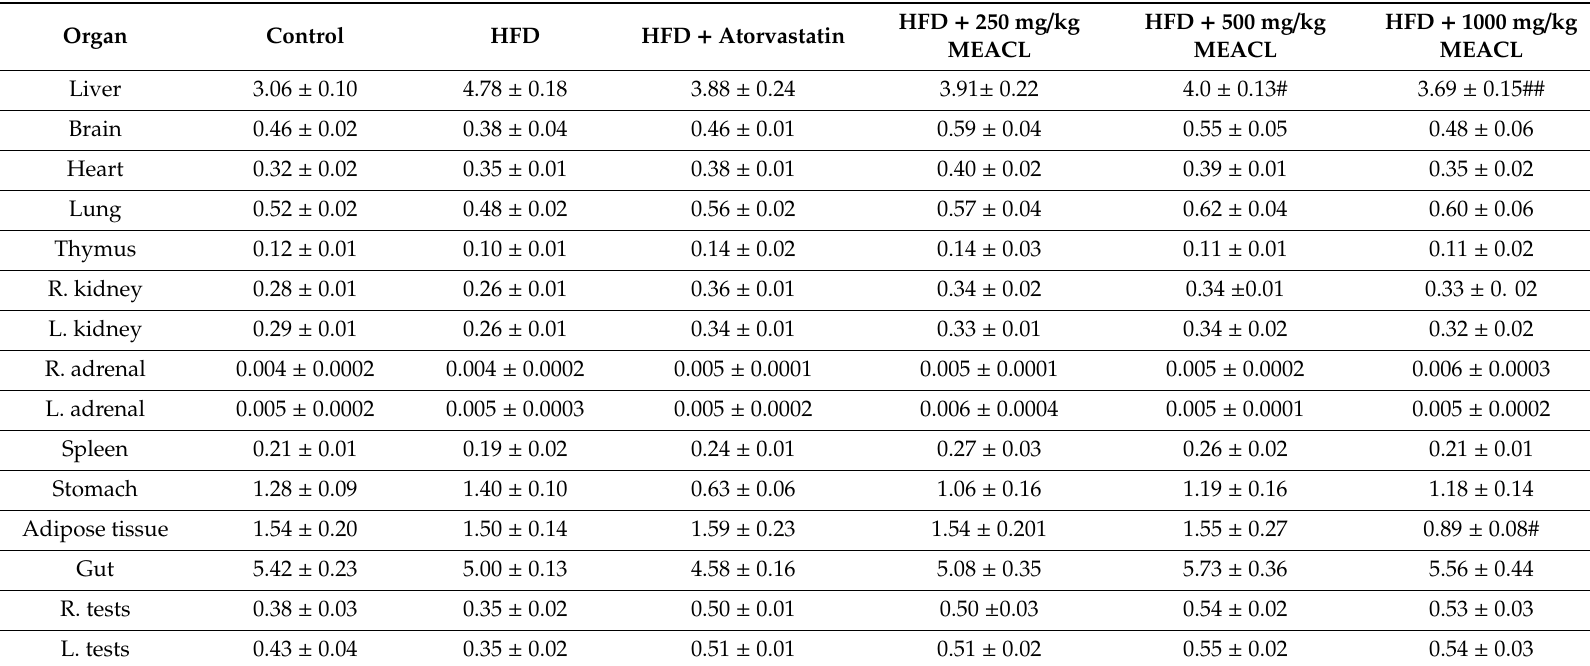
Abbreviations: L, left, R, right. Values are expressed as mean ± SEM, n = 6. # p < 0.05, ## p < 0.01 compared to hyperlipidemic